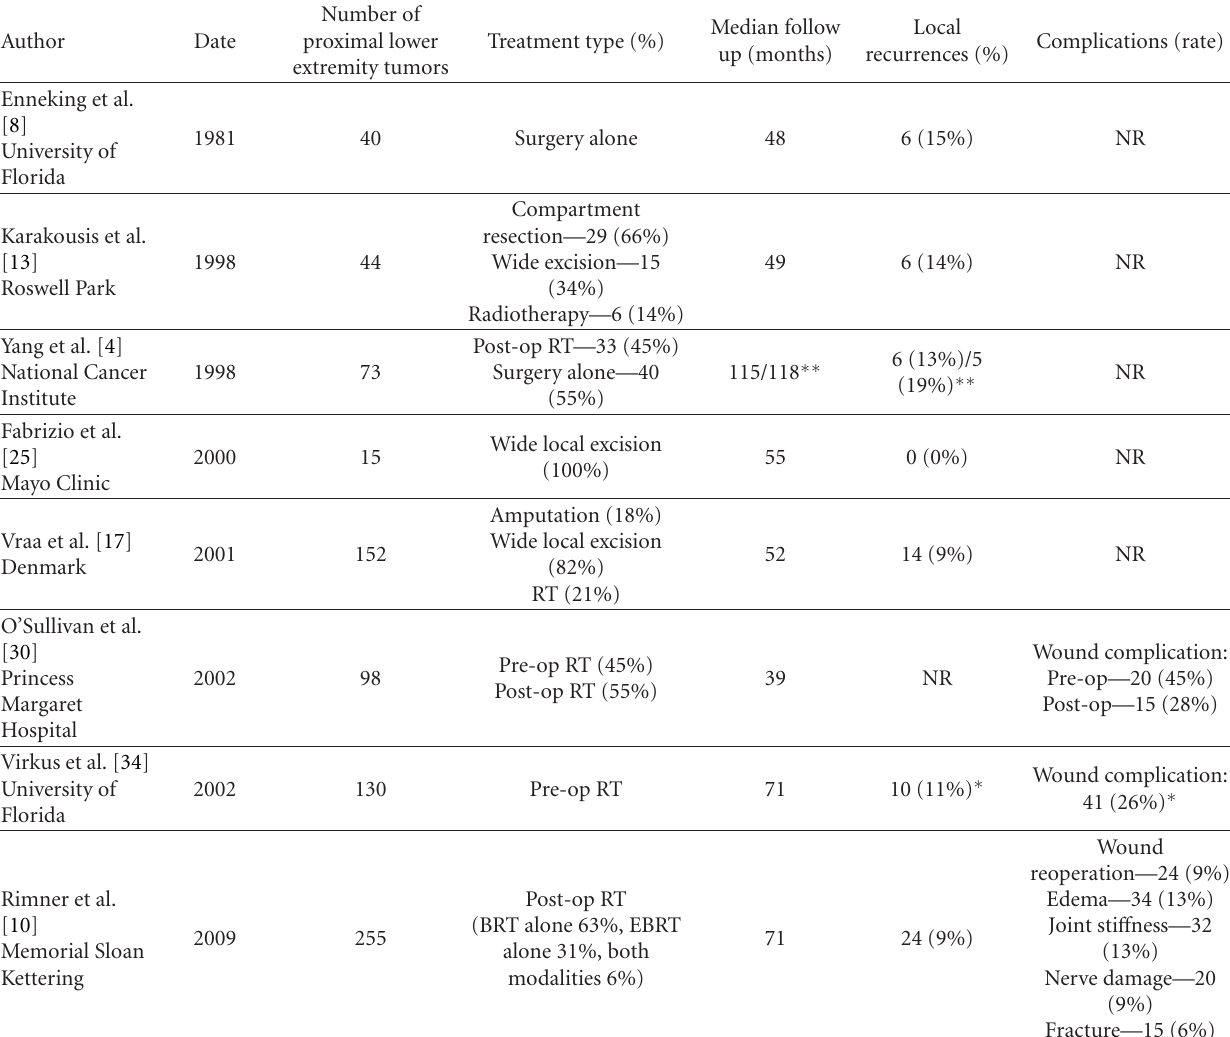
Table 1: Selected outcomes for proximal lower-extremity soft tissue